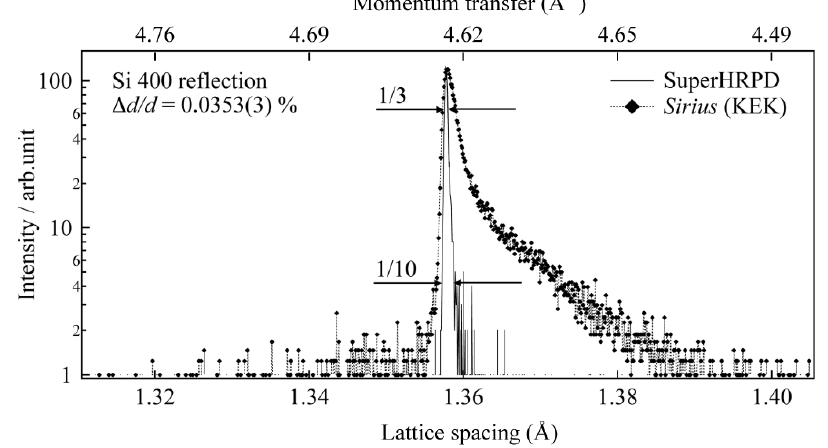
Figure 14. Comparison of neutron diffraction data for a silicon sample measured at super high-resolution powder diffractometer (SuperHRPD) (solid line) with those obtained at Sirius (dots) [40].